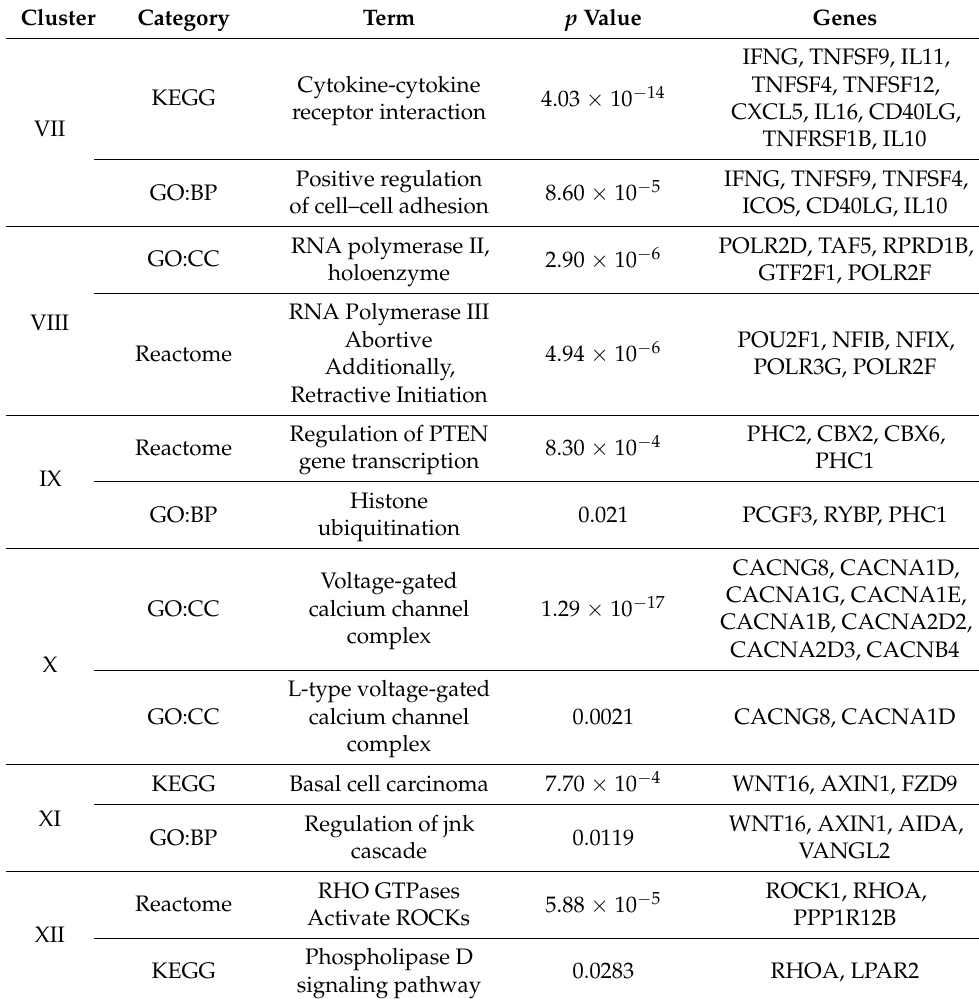
Table 5. Enrichment analysis of the six top-scored clusters separated from the PPI network of the genes regulated by upregulated miRNAs found in the current